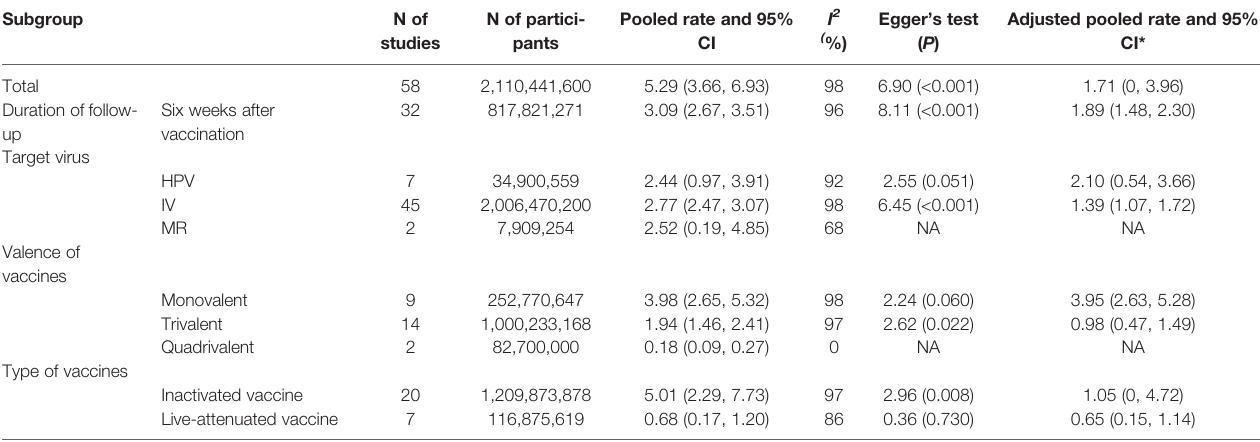
TABLE 2 | Subgroup analysis and trim- fi ll analysis of GBS incidence (per million